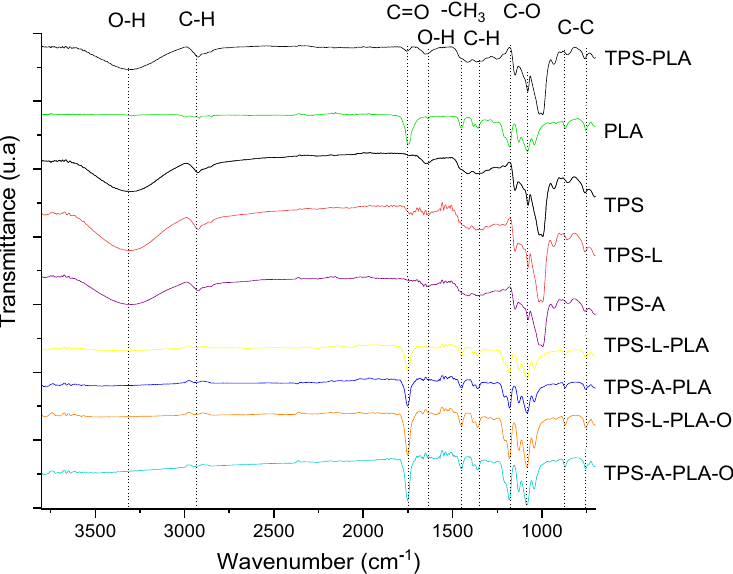
Figure 4. Fourier Transformed Infrared Spectroscopy (FTIR) spectra of the TPS and TPS/PLA sam- ples.